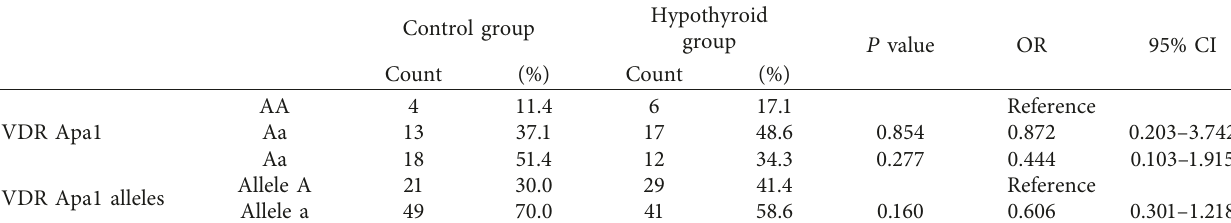
Table 3: Relation between alleles of Apa1 in both groups.